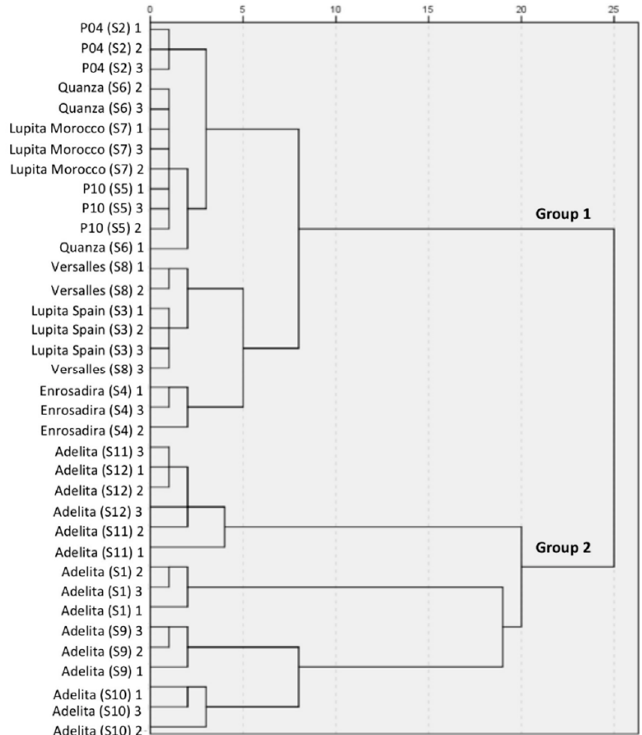
Figure 4. Hierarchical analysis dendrogram, obtained by cluster analysis method, of raspberry samples.